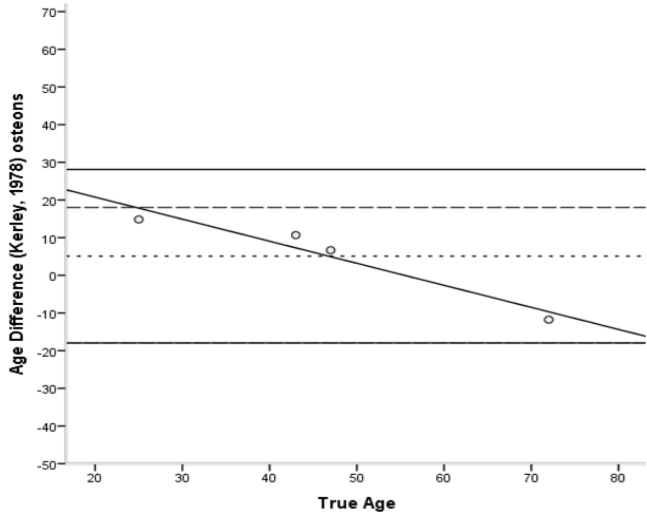
Figure 6. Bland–Altman plot for Kerley’s [33] intact osteon equation illustrating the differences between known and estimated ages for the femora against the known age. Depicted are 95% limits of agreement (black horizontal lines), mean difference/bias (black dotted line), best fit lines and 95% confidence intervals of the SEE for each method (dashed lines). R 2 of the best fit line: 0.933.